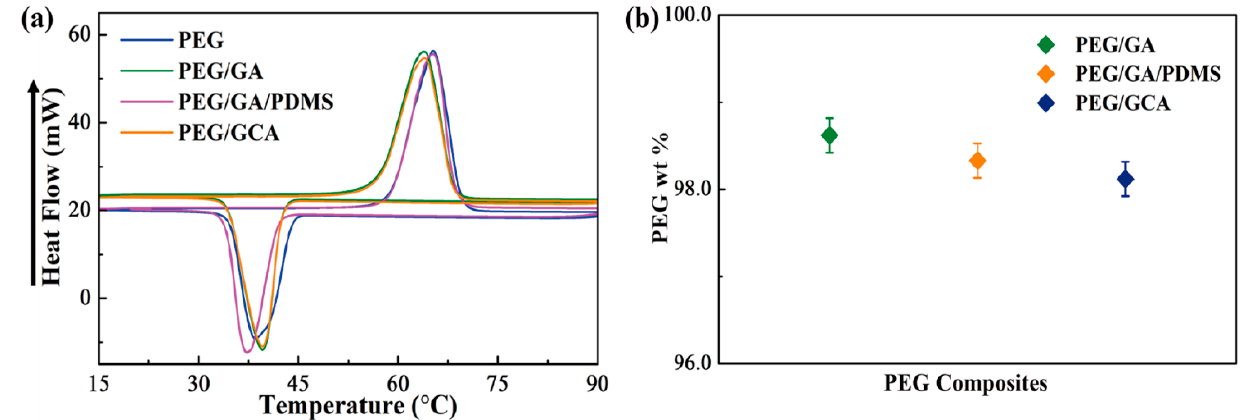
Figure 5. ( a ) Form-stable photographic images of pure PEG and PEG composites. ( b ) XRD peaks of supporting materials and PEG composites.